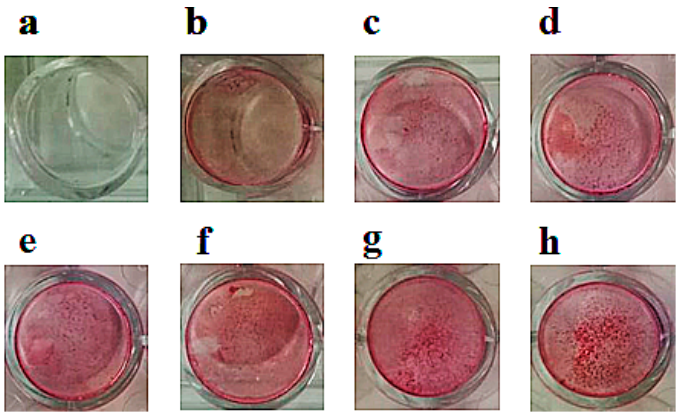
Figure 3. Mineralization assay with alizarin red S staining for calcium nodules after 15 days of incubation on MC3T3-E1 cells after treatments with alendronate (ALE), risedronate (RIS), and zoledronic acid (ZOL). Cells were treated with ( a ) normal medium, ( b ) mineralized medium, mineralized medium in the presence of ( c ) 3 × 10 − 8 M ALE, +38.68% ± 2.18% vs. mineralized medium in b, ( d ) 5 × 10 − 8 M ALE, +58.78% ± 6.08% vs. mineralized medium in b, ( e ) 3 × 10 − 8 M RIS, +45.13% ± 4.12% vs. mineralized medium in b, ( f ) 5 × 10 − 8 M RIS, +65.63% ± 5.22% vs. mineralized medium in b, ( g ) 3 × 10 − 8 M ZOL, +99.18% ± 31.28% vs. mineralized medium in b, ( h ) 5 × 10 − 8 M ZOL, +136.08% ± 21.48% vs. mineralized medium in b .